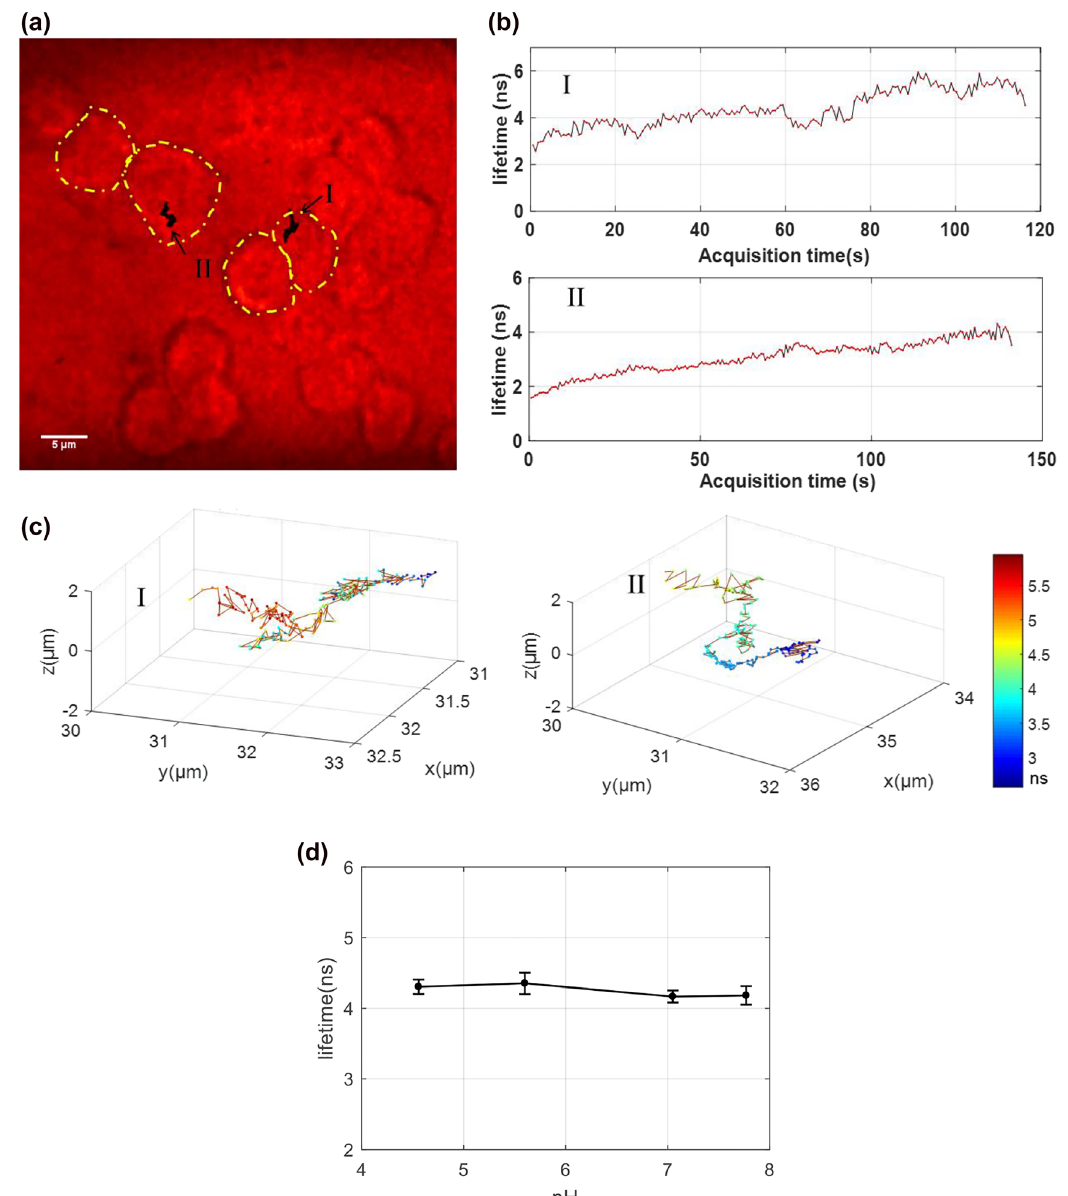
Figure 4: 4D tracking of particles during endocytosis in living RAW cells. (a) To demonstrate the localization of the particles within the cell, trajectories I and II were projected onto a transmission image of the cross- section of the cell of interest. (b) Fluorescence lifetime versus time for trajectories I and II shown in (a). (c) Traces I and II, as shown in (a), are plotted in 3D with pseudo color representing different fluorescence lifetimes. The color bar on the right indicates the fluorescence lifetime pseudo-color scale. (d) The fluorescence lifetime of the beads in different pH buffers, i.e., pH 4.56, pH 5.60, pH 7.05, and pH